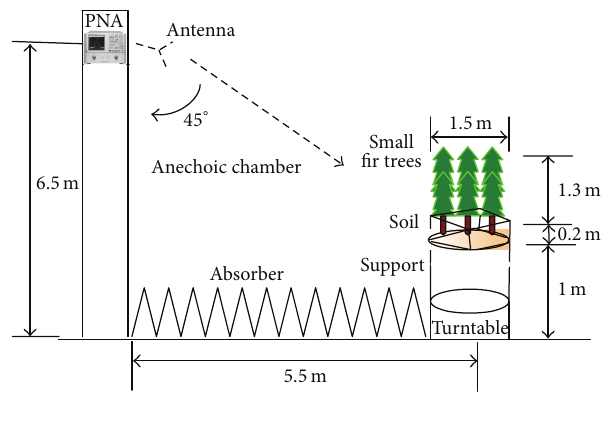
Figure 2: Measurement